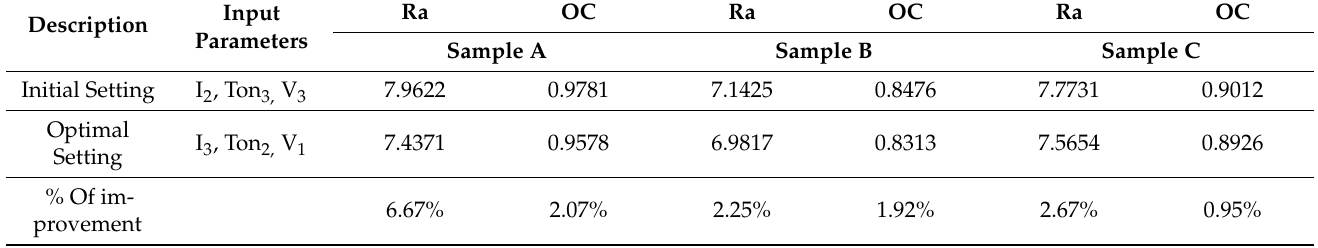
Figure 2. SEM image of machined surface at ( a ) 100X and ( b ) 800X at initial condition. Table 10. Percentage improvement in performance at optimal condition.